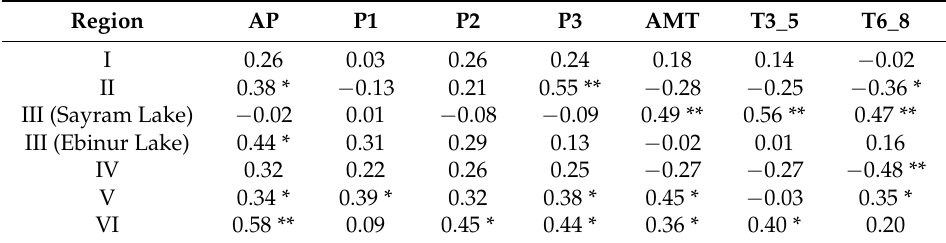
Table 2. Correlations between lake area and climate variables in each region (* and ** indicate the significance level of 0.10 and 0.05,